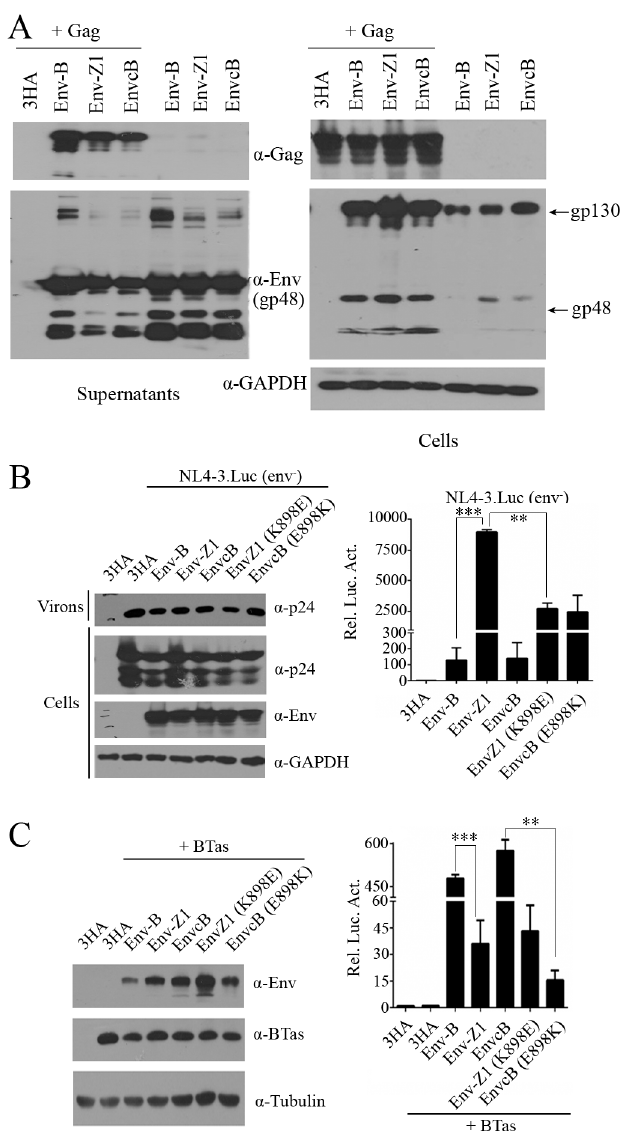
Figure 7. The C-terminal region of Env modulates the entry of cell-free BFV particles but does not affect virus release. ( A ) Immunoblot analysis of Gag and Env in HEK293T cells co-transfected with the indicated plasmids for 48 h and viral particles in supernatants. ( B ) Immunoblot analysis of HEK293T cells transfected with different HA-Env and NL4-3.luc (env - ). Luciferase reporter assays to